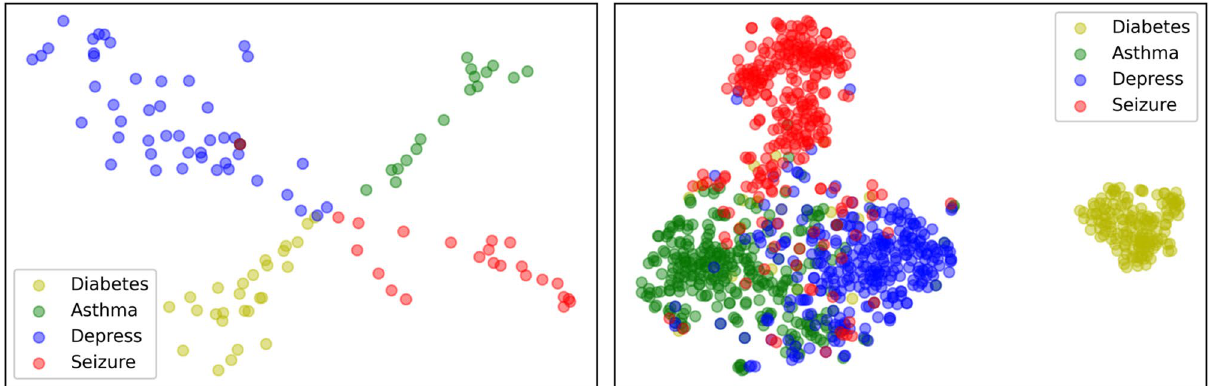
Figure 4. t-SNE scatter plots of diagnosis codes (left) and patients (right) learned by our framework. Four diseases (i.e., diabetes, asthma, depression, and seizure) are selected to provide clear visualization results. ICD-9 diagnosis codes (left) and patients (right) that describe the corresponding disease condition are